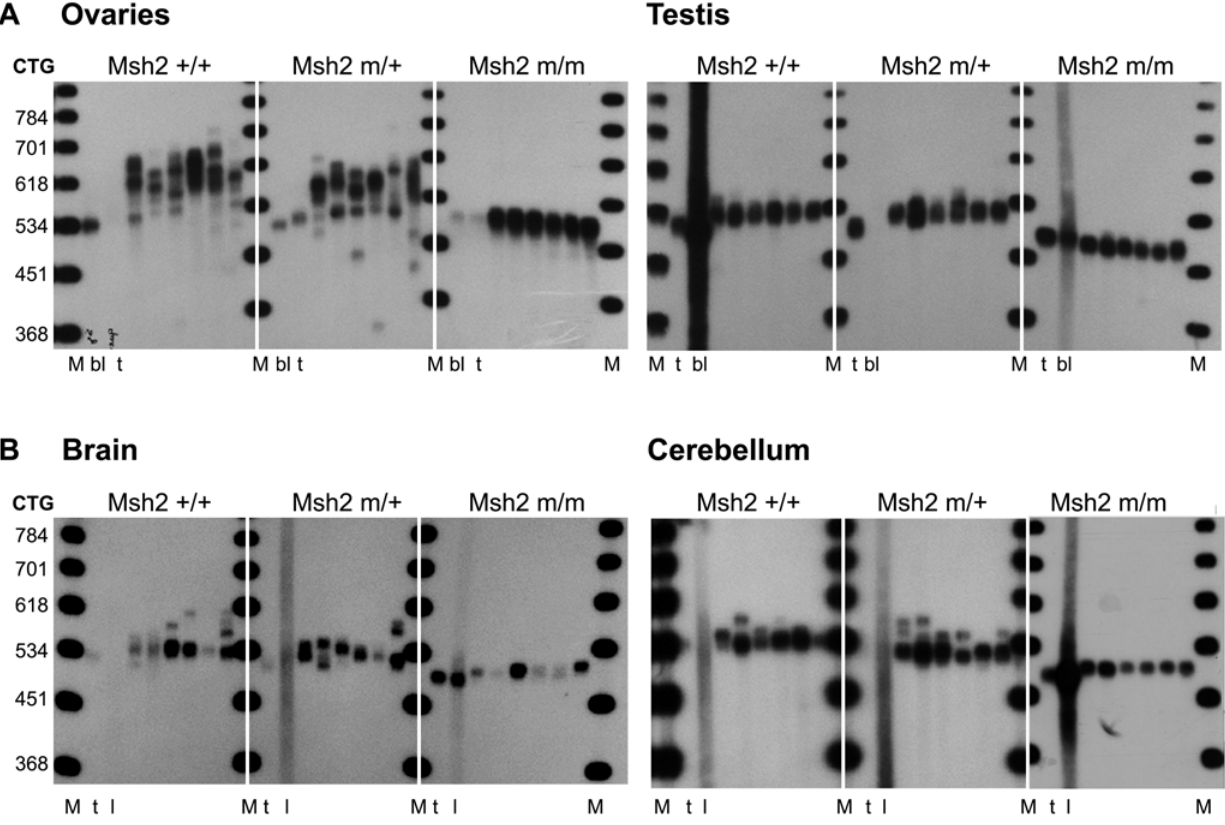
Figure 3. Representative SP-PCR analyses of CTG repeats in DNA molecules extracted from 8-month-old transgenic mouse tissues. The autoradiographs show representative SP-PCR analyses of DNA, extracted from ovaries and testis (A), brain and cerebellum (B). Genotypes are indicated. CTG repeat numbers determined in tail DNA at weaning are: 535 ( Msh2 + / + ); 512 ( Msh2 m/ + ); 499 ( Msh2 m/m ) in mice used to analyse DNA from ovaries and 525 ( Msh2 + / + ); 516 ( Msh2 m/ + ); 500 ( Msh2 m/m ) in the mice used for other tissues. t, tail; bl, blood; l, liver; M. 250 bp DNA ladder converted to number of repeat units in the given PCR product. About 2–10 amplifiable DNA molecules (ovaries, brain and cerebellum) and 10–50 transgene molecules (testis) were amplified. Msh2 + / + , m/ + and m/m represent genotypes at the murine locus for Msh2 . + : wild-type allele; m: Msh2 G674A